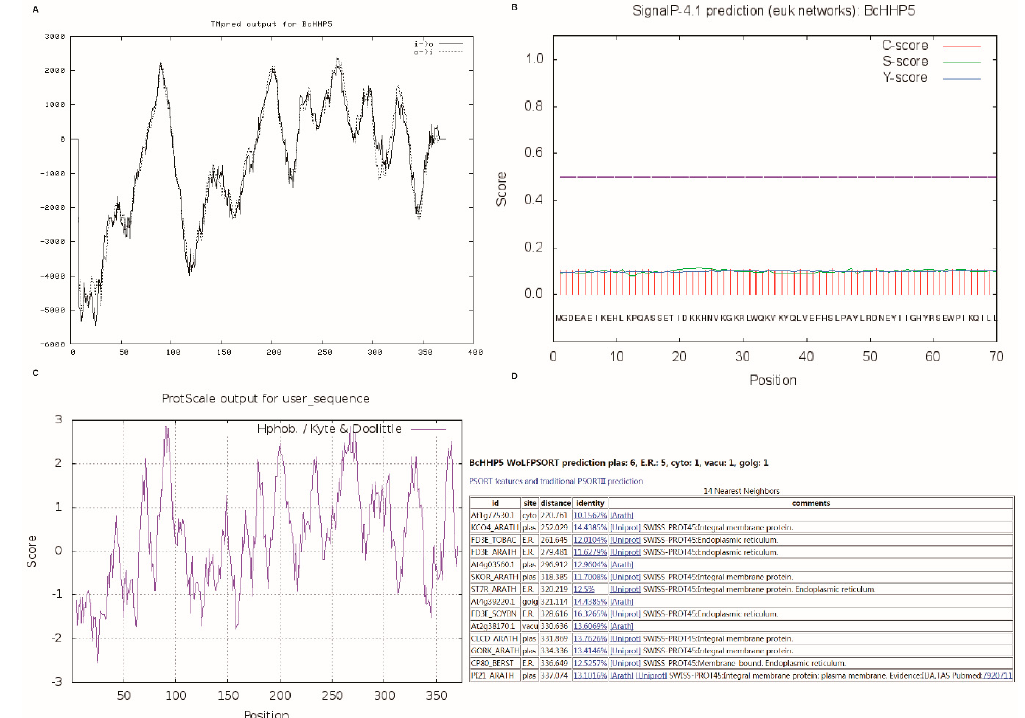
Figure 5. Related information of the BcHHP5 protein. ( A ) Transmembrane domain of the BcHHP5 protein; ( B ) signal peptide of BcHHP5 protein; ( C ) hydrophilicity of the BcHHP5 protein; and ( D ) subcellular localization prediction analysis of the BcHHP5 protein.